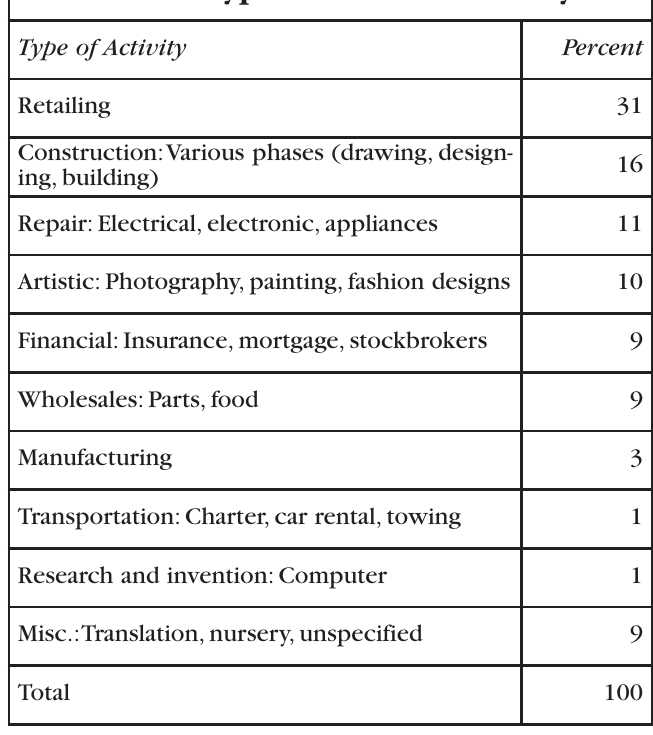
Table 2. Types of Business Activity